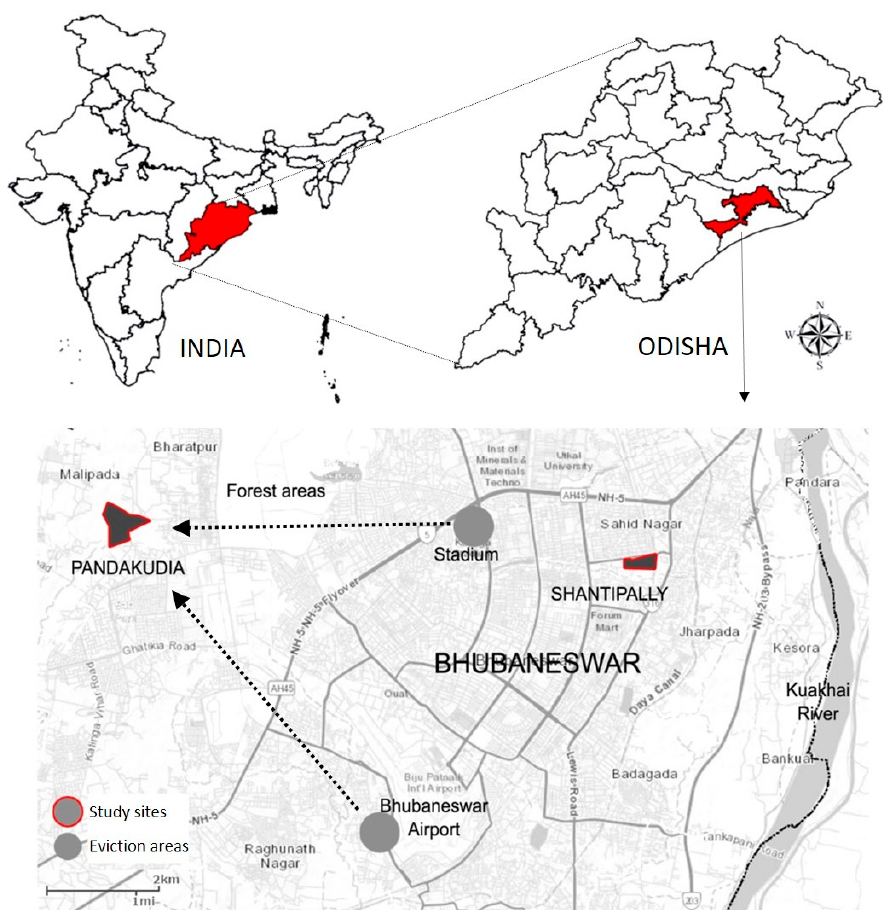
Figure 1. Location of the study area and two slum redevelopment sites in Bhubaneswar (maps sourced from bharatmaps.gov.in and OpenStreetMap (© OpenStreetMap contributors), images collated by authors) .